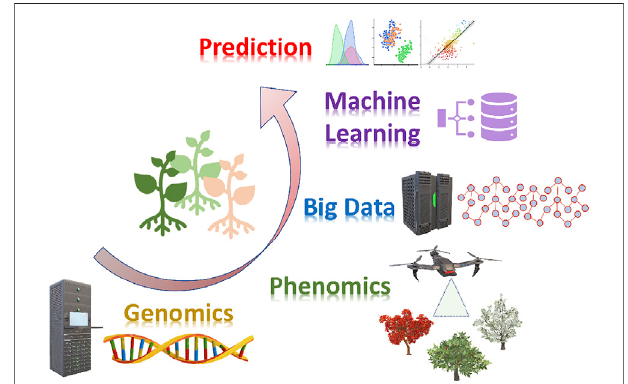
FIGURE 1 | Machine learning and its application for big data analysis in plantbreeding.Cuttingedgegenomicsandphenomicstechnologiesgenerate multi-omics datasets to be analyzed through machine learning approaches toward management and predictive data